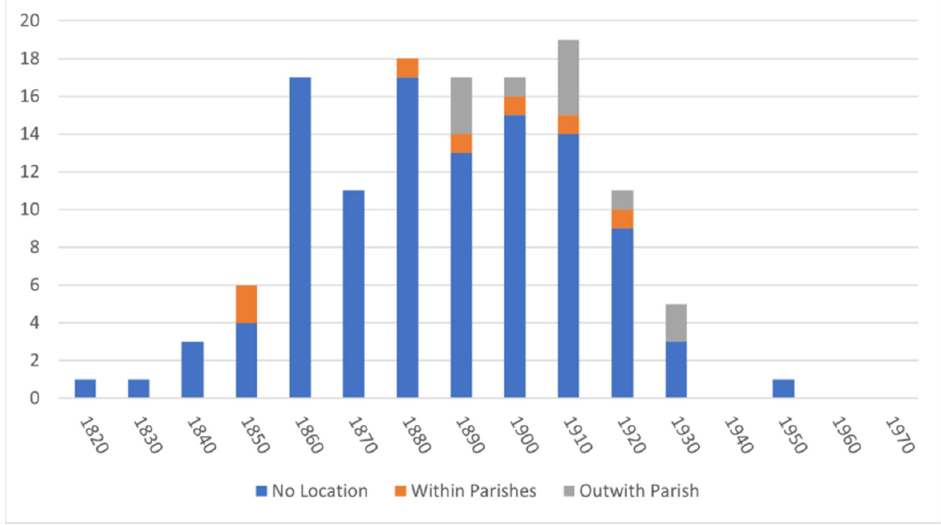
Figure 4. Distribution of inscriptions memorialising a location from Scockness Burial Ground.